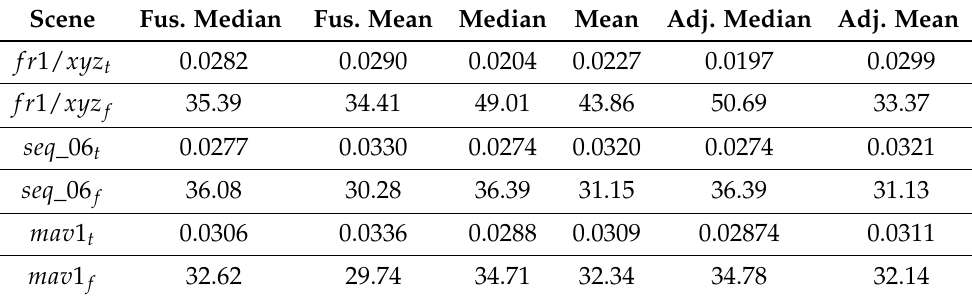
Table 6. Processing times of frames in seconds is presented by subscript t . The inverse is presented as frequency with a subscript f . “Fus.” represents the results of the fusion system. All the results are a mean for five passes. For each scene, the “media” and “mean” columns represent the median and mean of ORBSLAM2 system. “Adj.” represents the adjusted times/frequencies as explained in Section